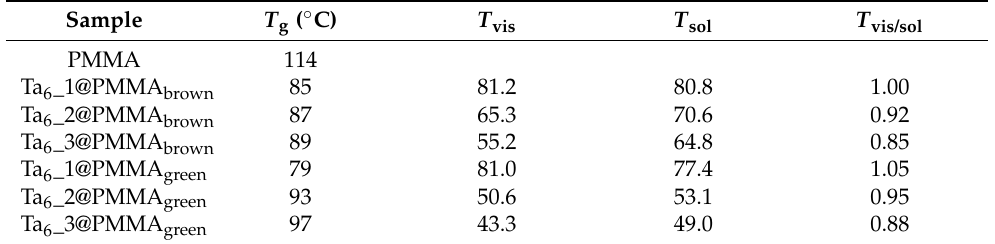
Table 2. Thermal behavior of films by DSC and FOM values of Ta 6 @PMMA nanocomposites.